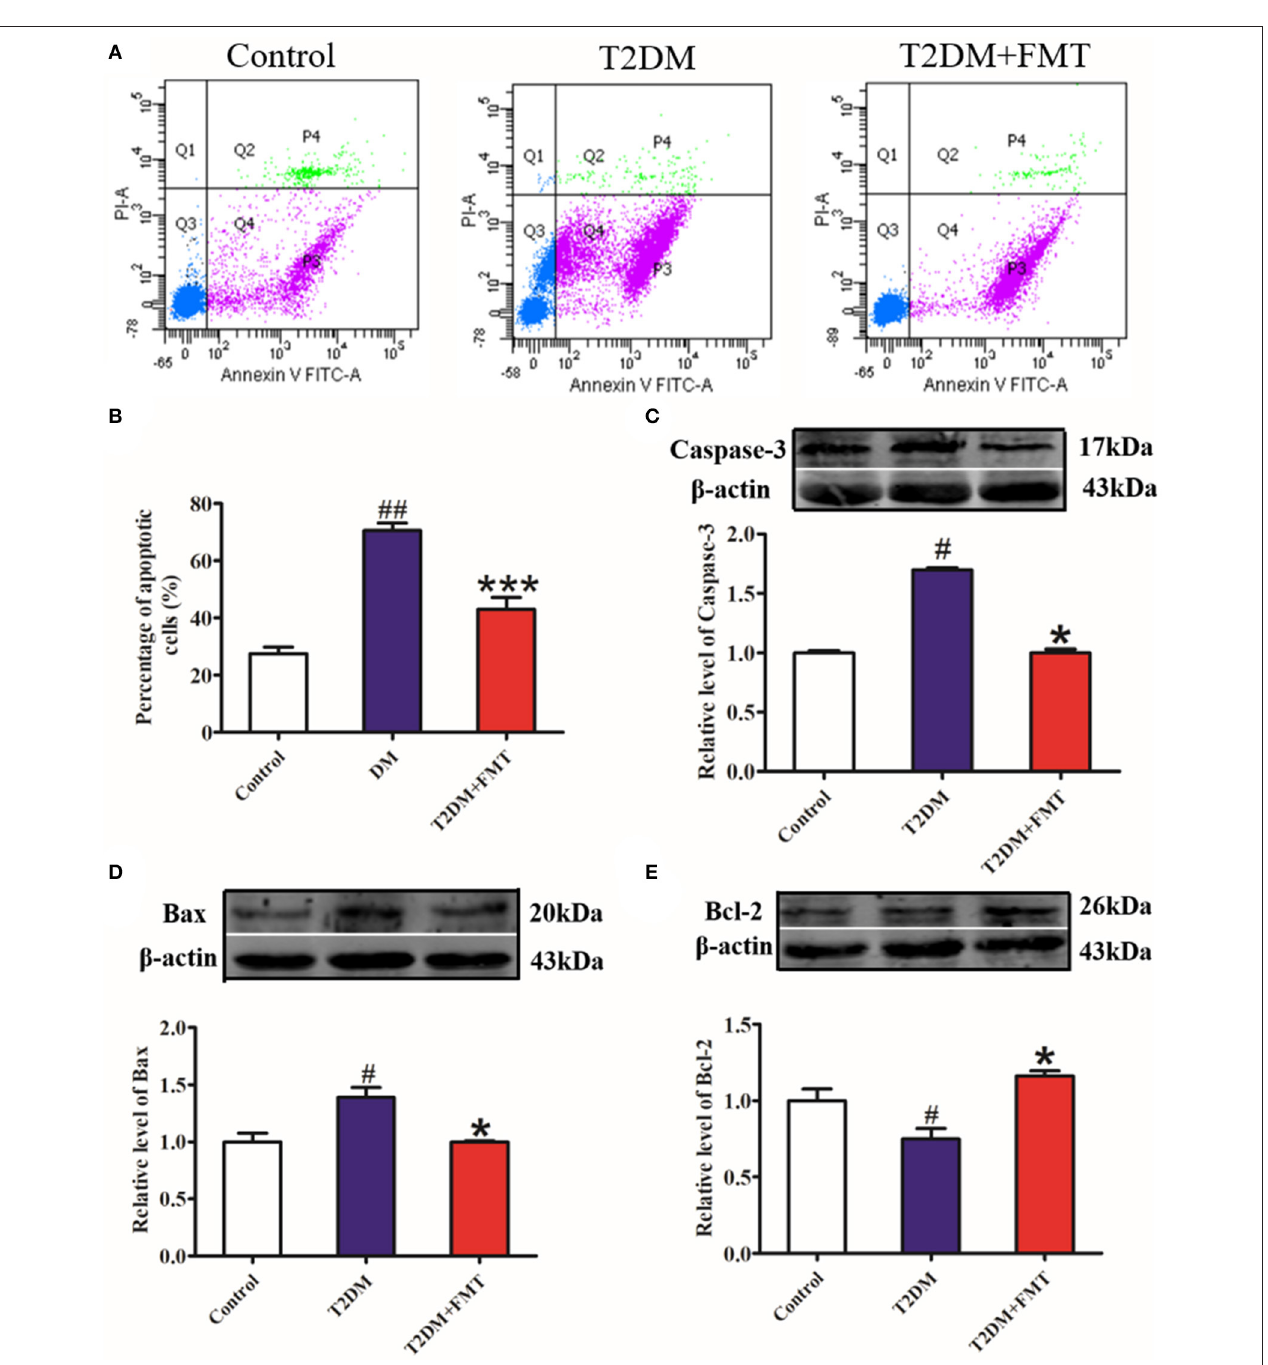
FIGURE 5 | The effect of FMT on apoptosis in pancreas tissue. (A) Representative flow cytometry images for pancreatic islet single cell. (B) Relative percentage of apoptosis cells in pancreas tissue calculated by flow cytometry. (C) The expression level of cleaved Caspase-3 in pancreas detected by western blot. (D) The expression level of Bax in pancreas detected by western blot. (E) The expression level of Bcl-2 in pancreas detected by western blot. * P < 0.05 vs. T2DM, *** P < 0.001 vs. T2DM, # P < 0.05 vs. Control, ## P < 0.01 vs. Control, n =